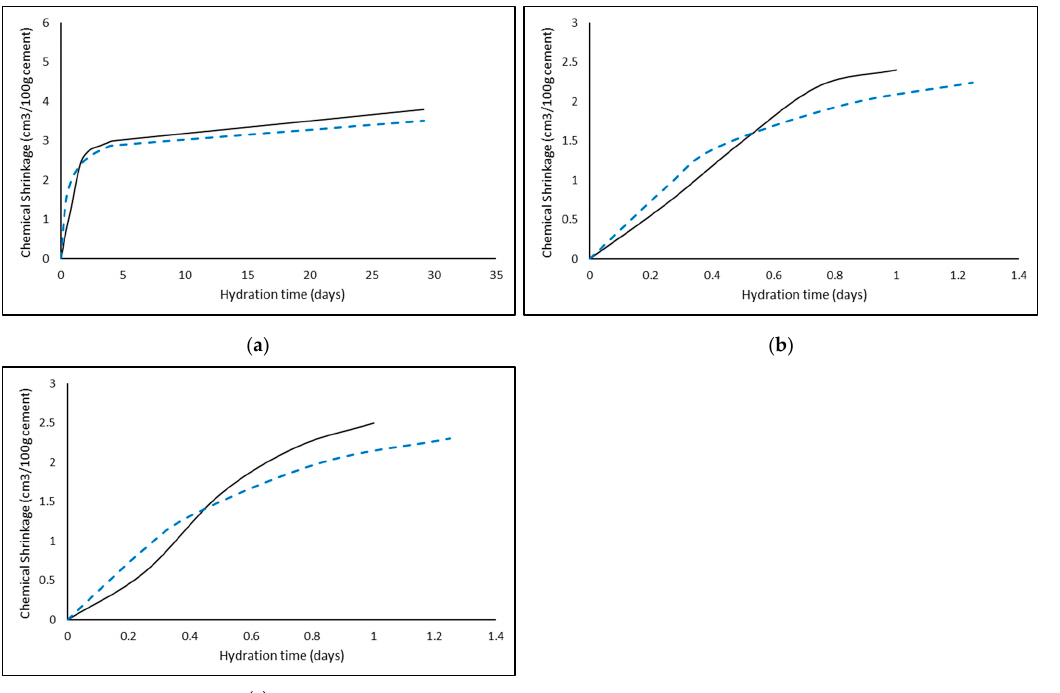
Figure 4. Relationship between predicted chemical shrinkage and degree of hydration (using [22]) for the ( a ) CEM I and ( b ) CEM II cements.